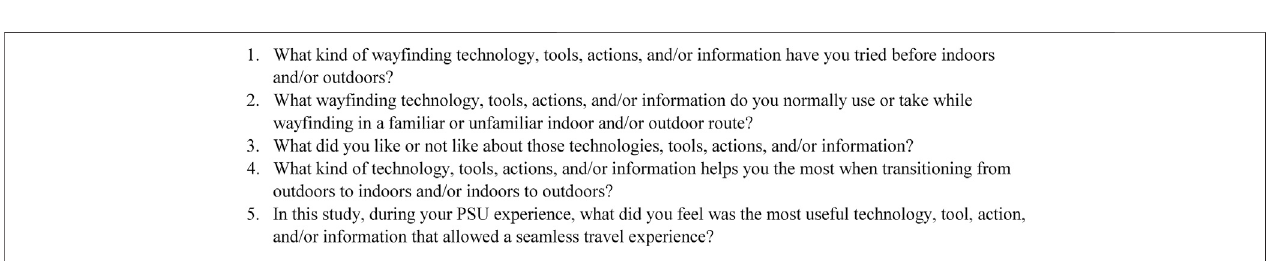
FIGURE 3 | Overview of the questions for the semi-structured interview which we conducted with the participant shortly after having completed the way fi nding experiment.